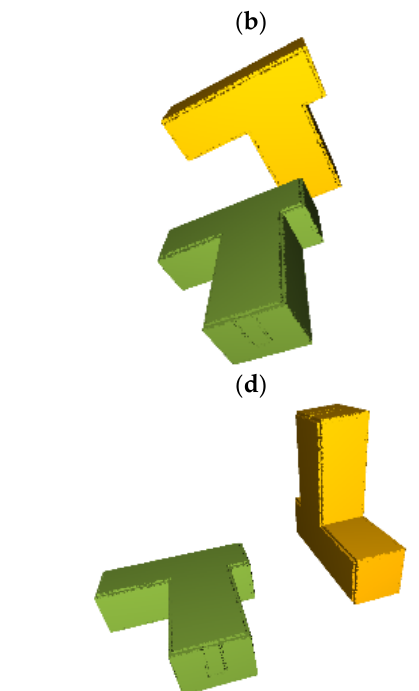
Figure 10. Visualization of the corresponding as-built model (yellow) relative to the as-planned model (green) sorted with rotation matrices having matching costs (𝜎): ( a ) 𝜎(𝑡 𝑅 1 𝑜 ) = 0.4304, ( b ) 𝜎(𝑡 𝑅 2 𝑜 ) = 4.8754, ( c ) 𝜎(𝑡 𝑅 3 𝑜 ) = 5.0401 and, ( d ) 𝜎(𝑡 𝑅 4 𝑜 ) = 5.5786.